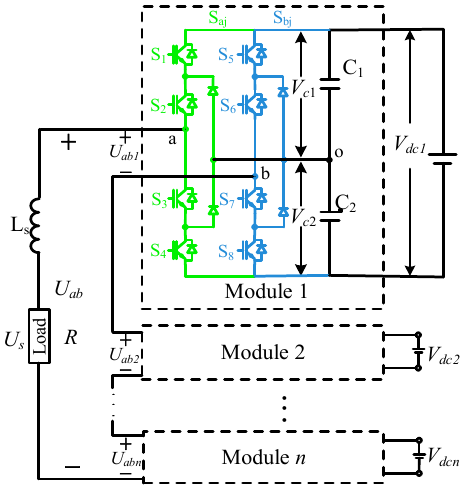
Figure 1. Topology of 3LNPC-CC.